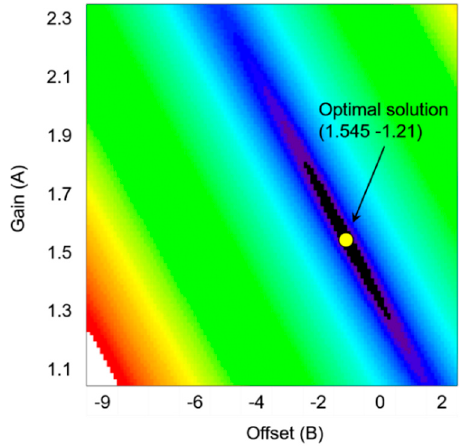
Figure 15. Distribution of the evaluation value in searching the optimum solutions of the gain ( A ) and the offset ( B ) for the period of D = 1045 to 1134 for ALOS-2/CIRC. The optimal solution obtained is also shown.